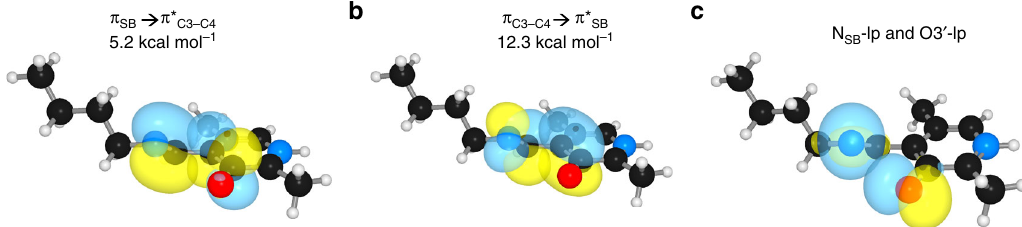
Fig. 7 Natural bond orbitals in the N SB -deprotonated/N1-protonated internal aldimine model. a π SB − C4 ′ → π * C3 − C4 , b π C3 − C4 → π * SB − C4 ′ , and c lone-pair (lp)